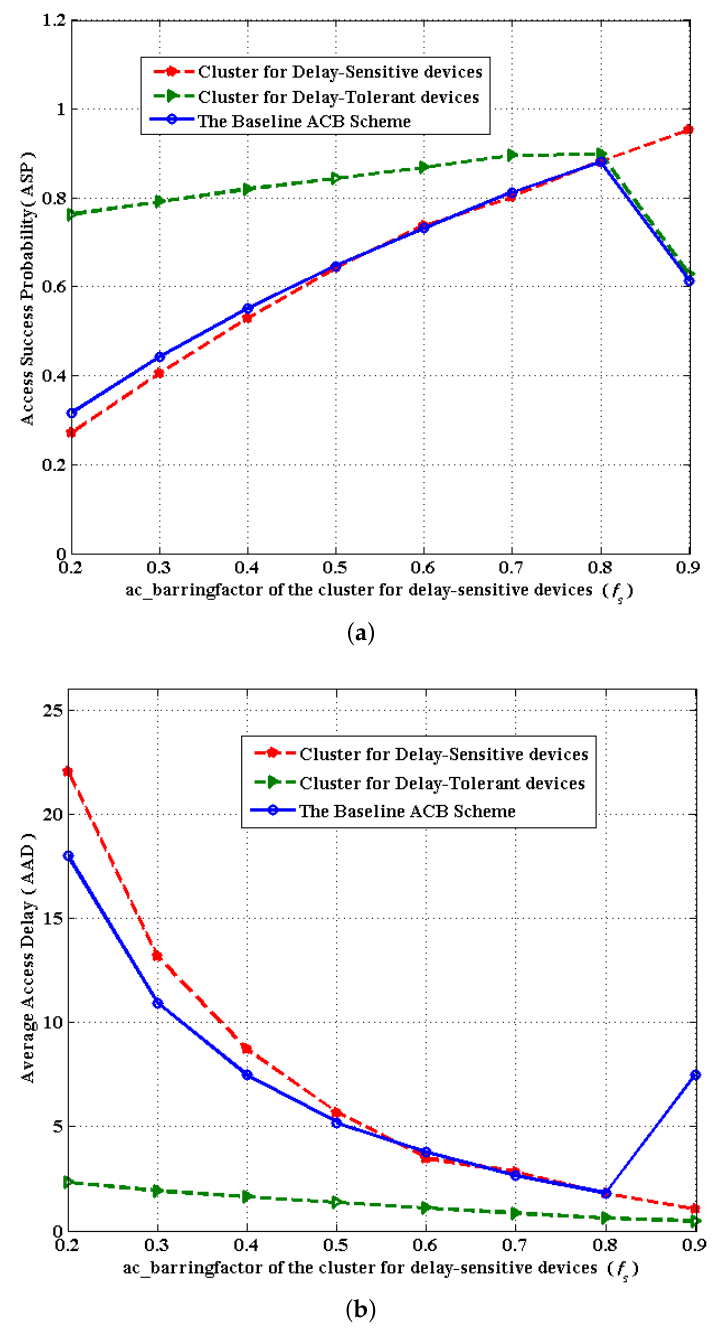
Figure 10. Performance comparison between two clusters for delay-sensitive and delay-tolerant devices and the baseline ACB scheme. ( a ) The ASP versus f s between two clusters and the baseline ACB scheme; ( b ) the AAD versus f s between two clusters and the baseline ACB